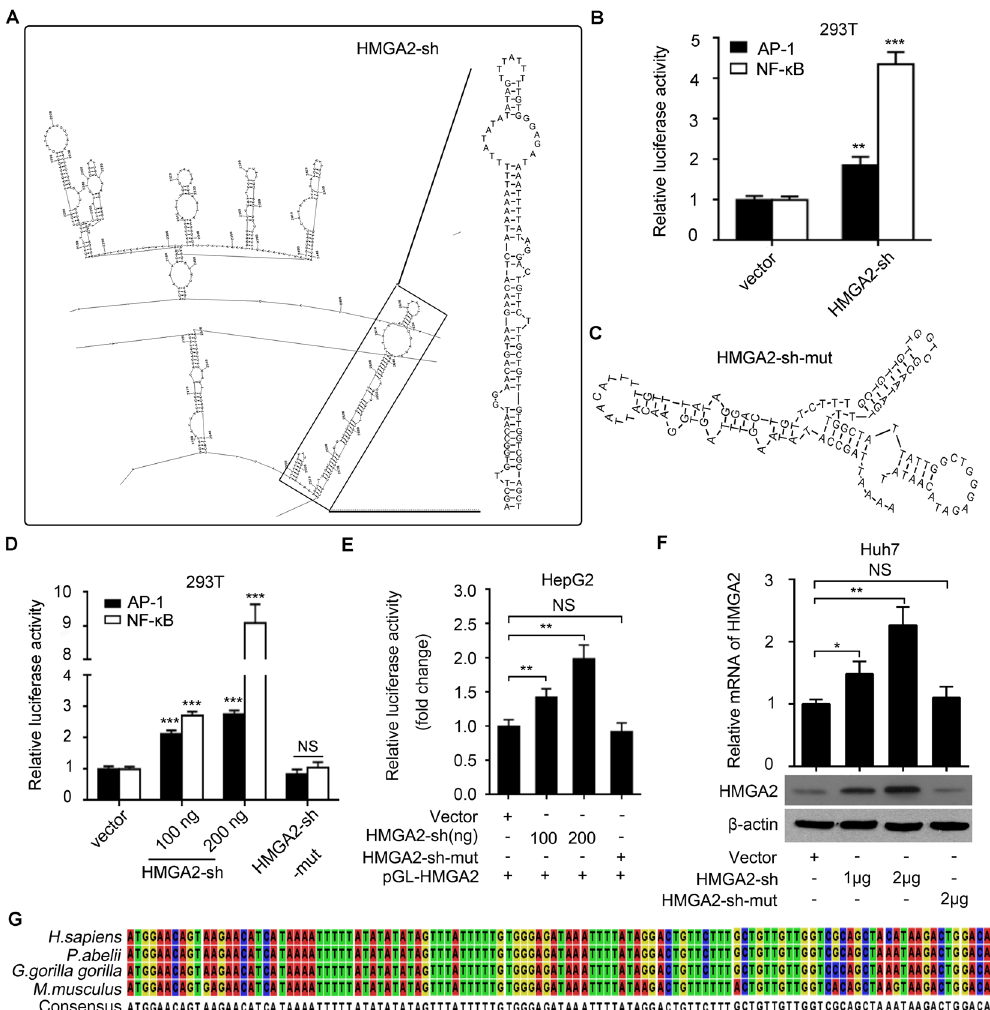
Figure 1. A hairpin within HMGA2 mRNA 3 ′ UTR has regulatory function. ( A ) The secondary structure of HMGA2 3 ′ UTR was analyzed by using RNAstructure. ( B ) The promoter activities of AP-1 and NF- κ B were examined by luciferase reporter gene assays in 293T cells. ( C ) The secondary structure of HMGA2-sh-mut with cripple of HMGA2-sh sequence was analyzed by using RNAstructure. ( D ) The promoter activities of AP-1 and NF- κ B were measured by luciferase reporter gene assays in 293T cells. ( E ) The luciferase activities of pGL3- HMGA2 were determined by luciferase reporter gene assays in HepG2 cells. ( F ) The expression of HMGA2 was assessed by qRT-PCR and Western blot analysis in Huh7 cells. ( G ) The sequence alignment of HMGA2-sh in different species was analyzed by the software of CLC sequence viewer 6.3. Every experiment was repeated three times. Error bars represent s.d. (n = 3), ** p < 0.01; *** p < 0.001 and not significant (NS), Student’s t HMGA2-sh-3p20 upregulates HMGA2 by blocking the TTP-mediated degradation of HMGA2 mRNA. To better understand the significance of HMGA2-sh-3p20, we evaluated its expression in clinical HCC tissues. Interestingly, qRT-PCR assays showed that the levels of HMGA2-sh-3p20 were higher in HCC tis- sues relative to their peritumor liver tissues in 35 paired clinical HCC samples ( P < 0.001; Wilcoxon’s signed-rank test, Fig. 3A). Furthermore, the levels of HMGA2-sh-3p20 were positively associated with those of HMGA2 mRNA in the afore-mentioned clinical samples ( P < 0.01; Pearson correlation, Fig. 3B). Luciferase reporter gene assays showed that HMGA2-sh-3p20 was able to elevate the activities of pGL-HMGA2 containing HMGA2-sh in HepG2 (or 293T) cells (Fig. 3C and Supplementary Fig. S3A). Moreover, the overexpression of HMGA2-sh-3p20 resulted in the upregulation of HMGA2 at the levels of mRNA and protein in a dose-dependent manner in Huh7 (or HepG2) cells (Fig. 3D and Supplementary Fig. S3B). The inhibitor of HMGA2-sh-3p20 failed to downregu- late the expression of HMGA2 at the levels of mRNA and protein (Supplementary Fig. S3C), implying that the levels of HMGA2-sh-3p20 are lower in hepatoma cells. However, HMGA2-sh-3p20 inhibitor could decrease the expression of HMGA2 at mRNA levels in a dose-dependent manner in HepG2 cells when transiently transfected with HMGA2-sh (Supplementary Fig. S3D). It has been reported that TTP can lead to the degradation of mRNA by directly binding to ARE located in the mRNA 3 ′ UTR 32 (Fig. 3E). MiR-466l upregulates IL-10 mRNA levels by preventing TTP binding to the AREs,